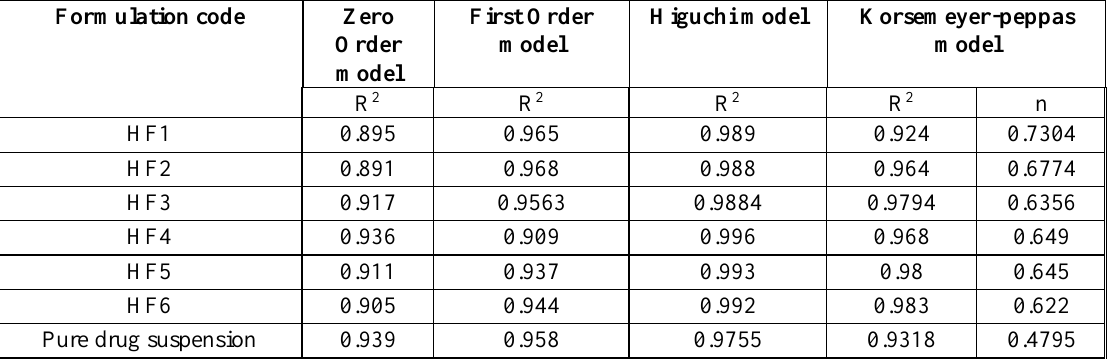
Table 4. The correlation coefficient (R 2 ) and release exponent (n) of different kinetic models of felodipine